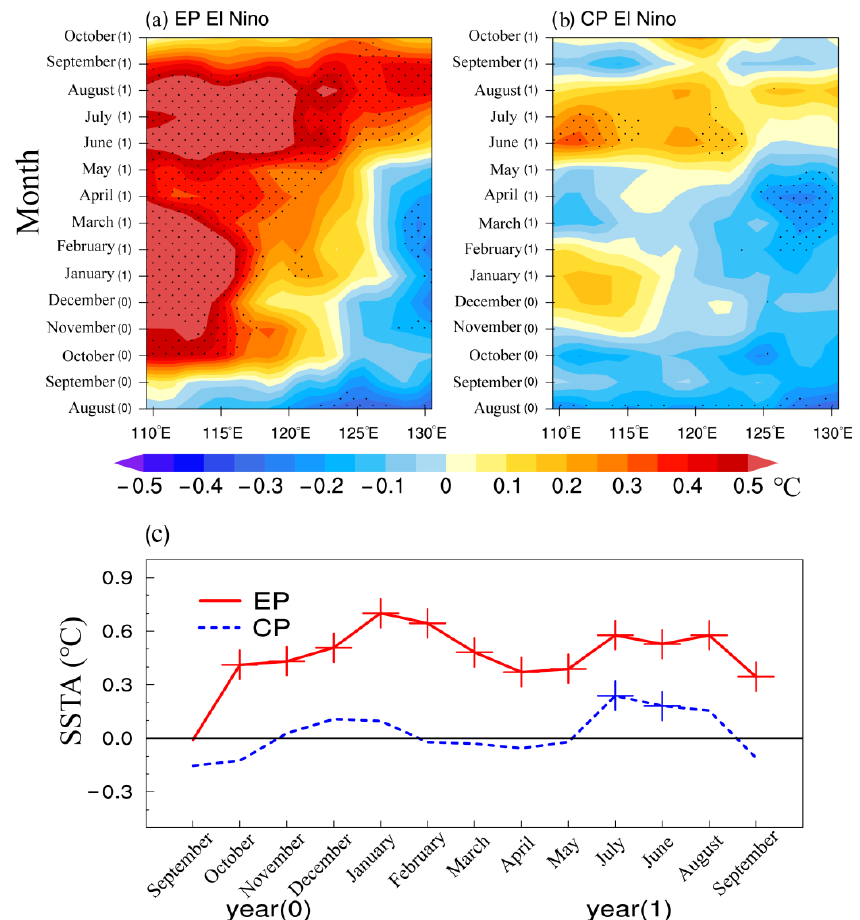
Figure 2. Evolution of the composite SSTA (°C) within the 10–13° N band for ( a ) EP El Niño and ( b ) CP El Niño events. ( c ) Time series of the averaged SSTA (°C) over the CT region (110–118° E, 10–13° N) in EP (red solid line) and CP (blue dashed line) El Niño events. The stippled areas in ( a , b ) and “+” symbols in ( c ) indicate values exceeding the 90% confidence level.